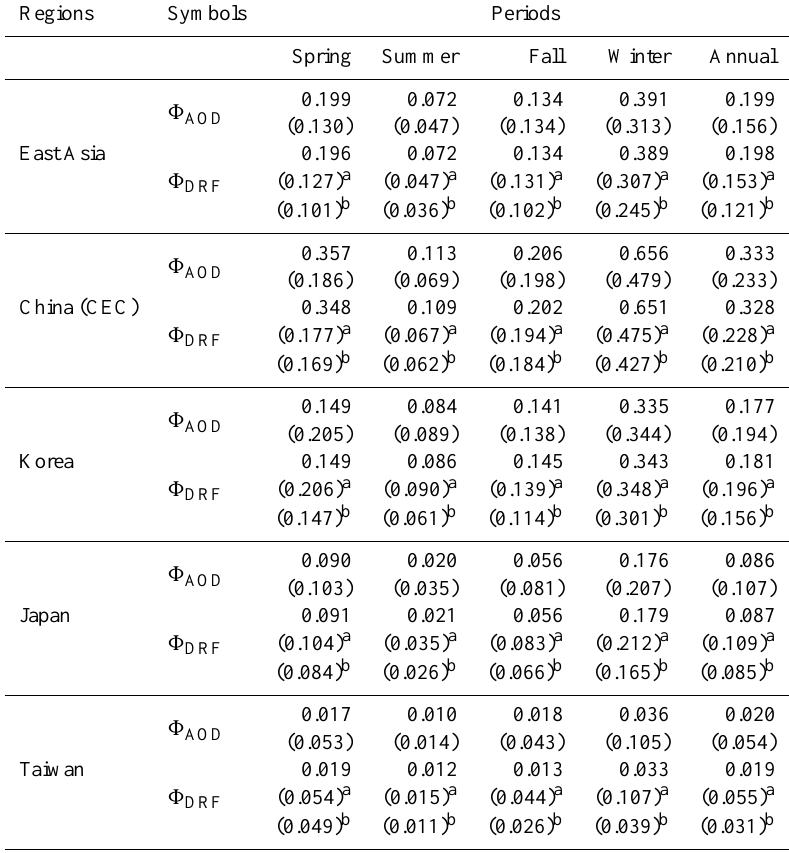
Table 2. The contribution of ammonium nitrate to AODs and DRFs ( 8 c Korea, Japan, and Taiwan under clear-sky and all-sky